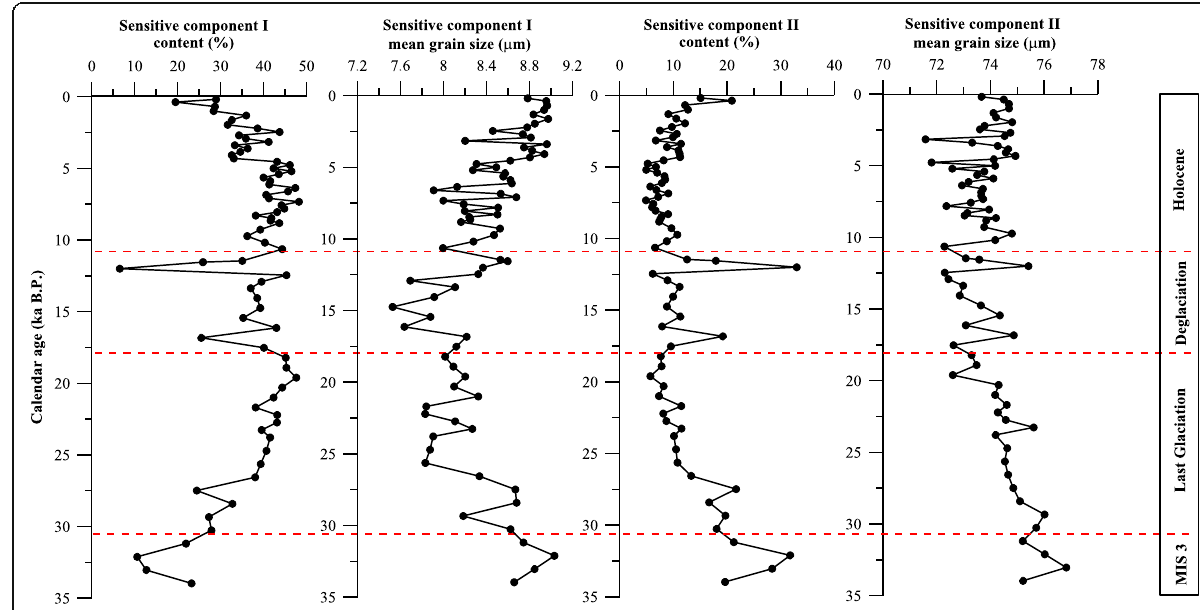
Fig. 5 Content and mean grain size of two sensitive components from core